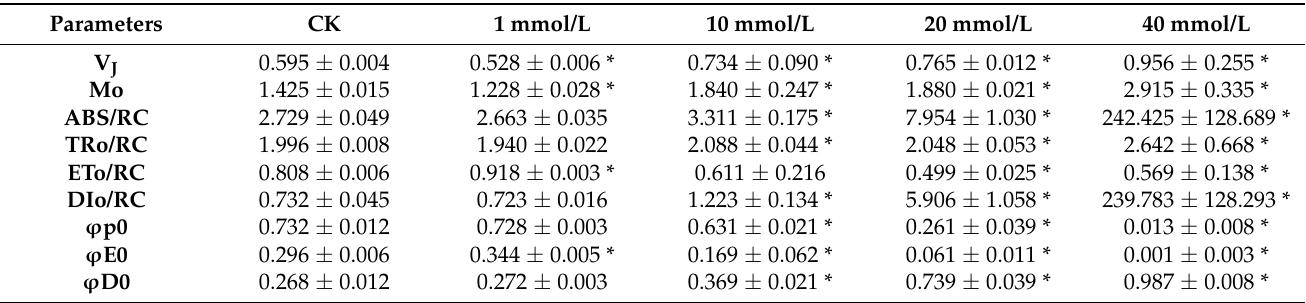
Table 1. The parameters of Chl a fluorescence induction kinetics under various concentrations of glyphosate in Chlorella vulgaris .